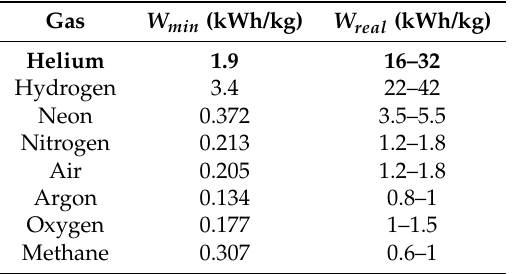
Table 5. Minimal work ( W min ) and real work W real for condensation gases [25].